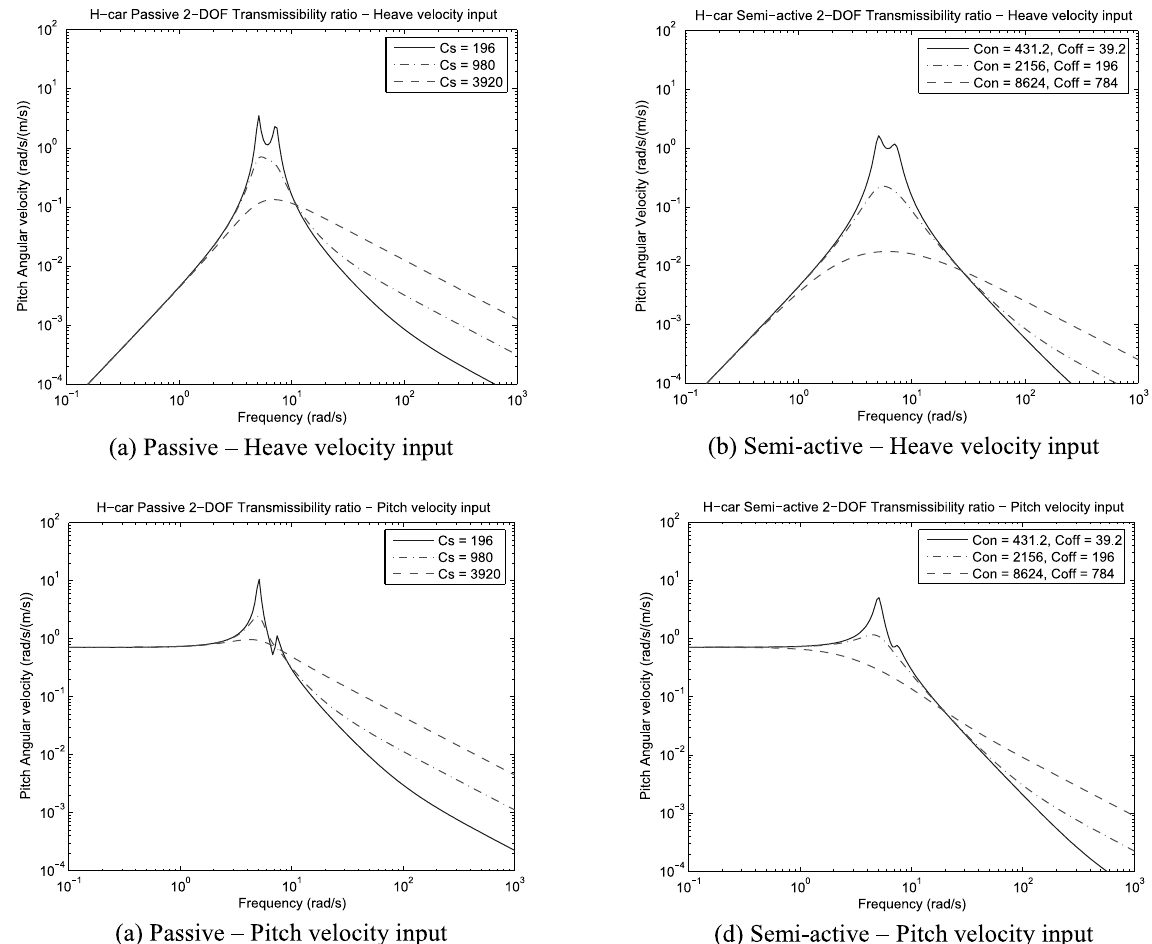
Fig. 4. Transmissibility ratio of pitch angular velocity for various damping